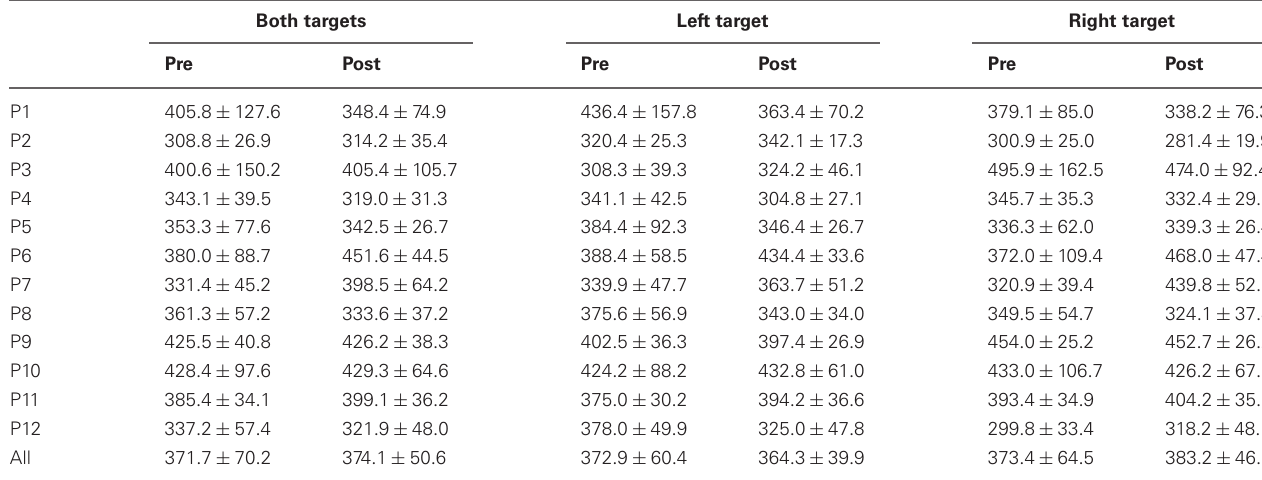
Table 4 | Mean ± Standard deviation of peak velocity in degrees per second for both, left, and right targets in the two periods, for every participant and the group of participants